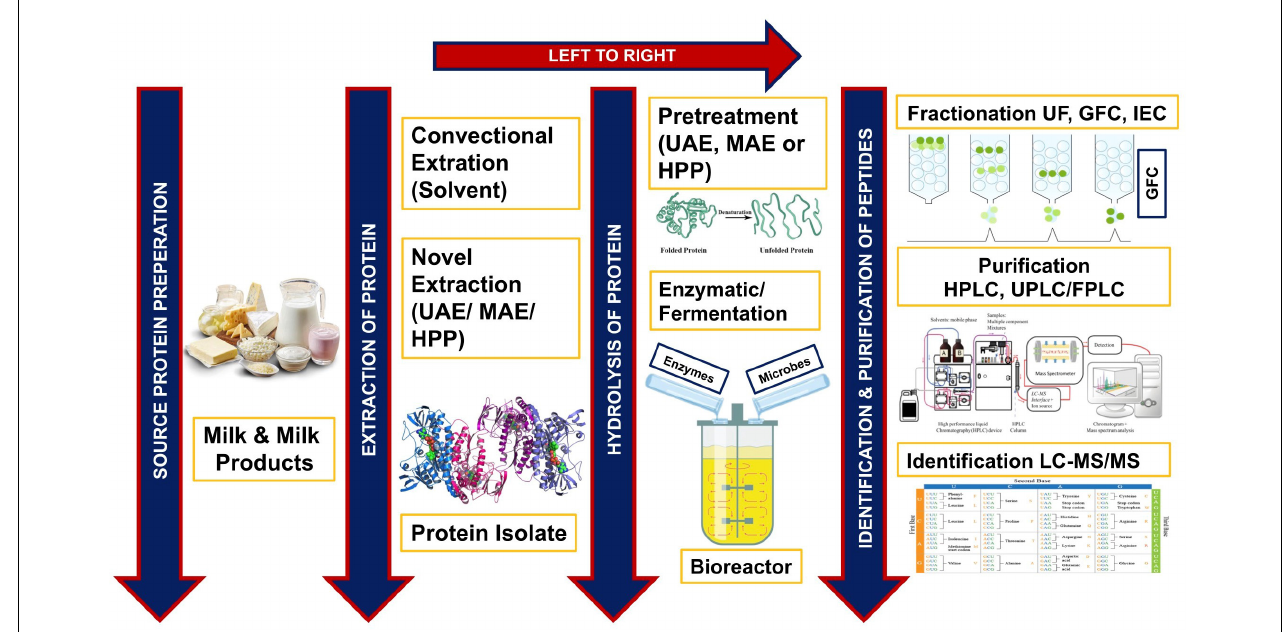
FIGURE 1 | Schematic diagram of the production of bioactive peptides from dairy products.